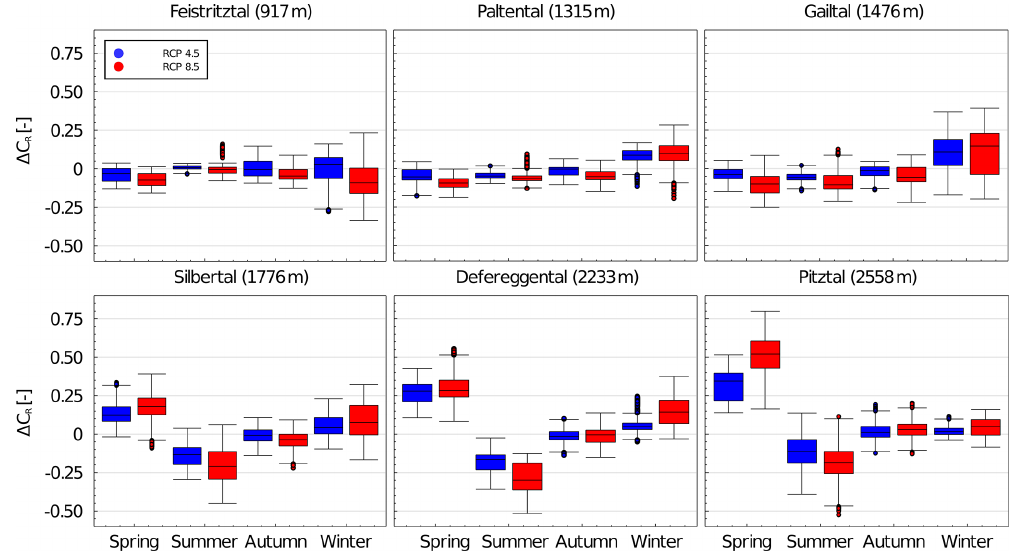
Figure 8. Absolute changes in mean seasonal runoff coefficient ( (cid:49)C R (–)) across all 14 simulations for the six study catchments and both scenarios RCP4.5 and RCP8.5 (spring – March–May; summer – June–August; autumn – September–November; winter – December– February). Mean catchment elevation is given in